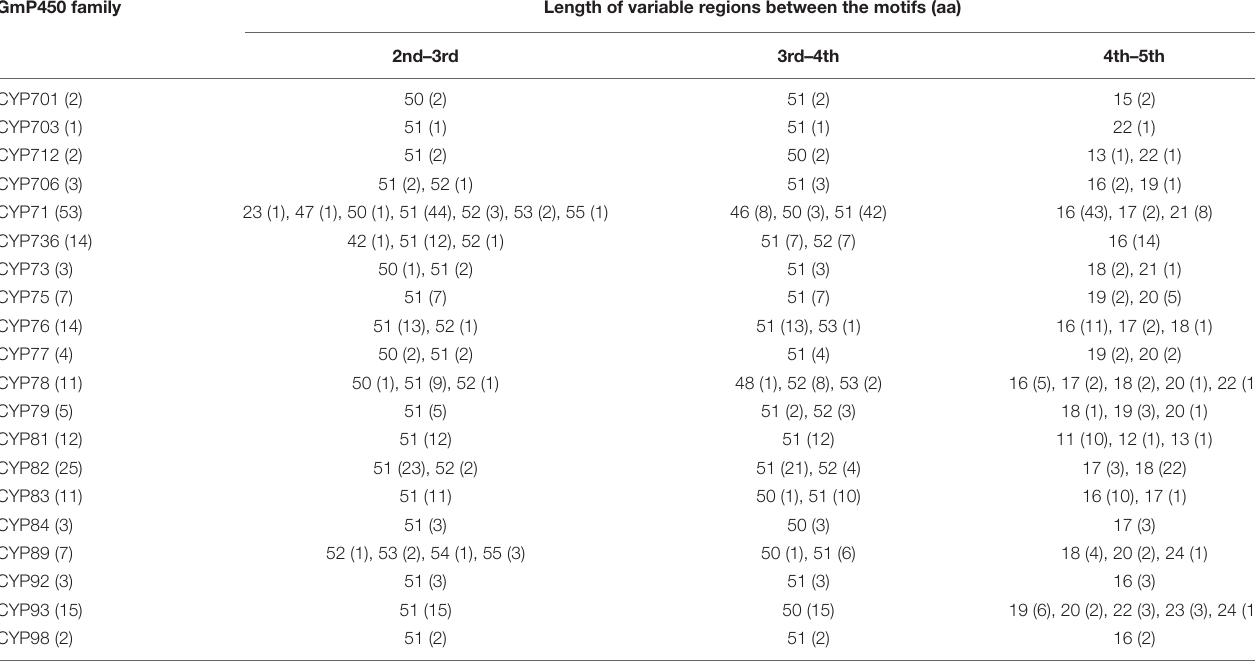
TABLE 3 | Length of variable regions between the conserved motifs in A-type GmP450 families. GmP450 family Length of variable regions between the motifs (aa)